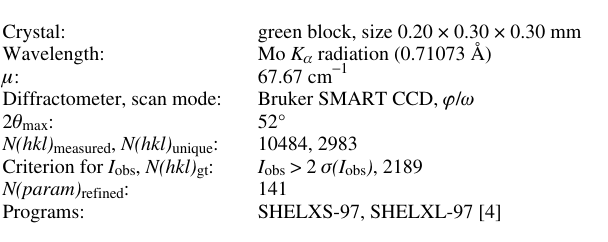
Table 1. Data collection and handling.